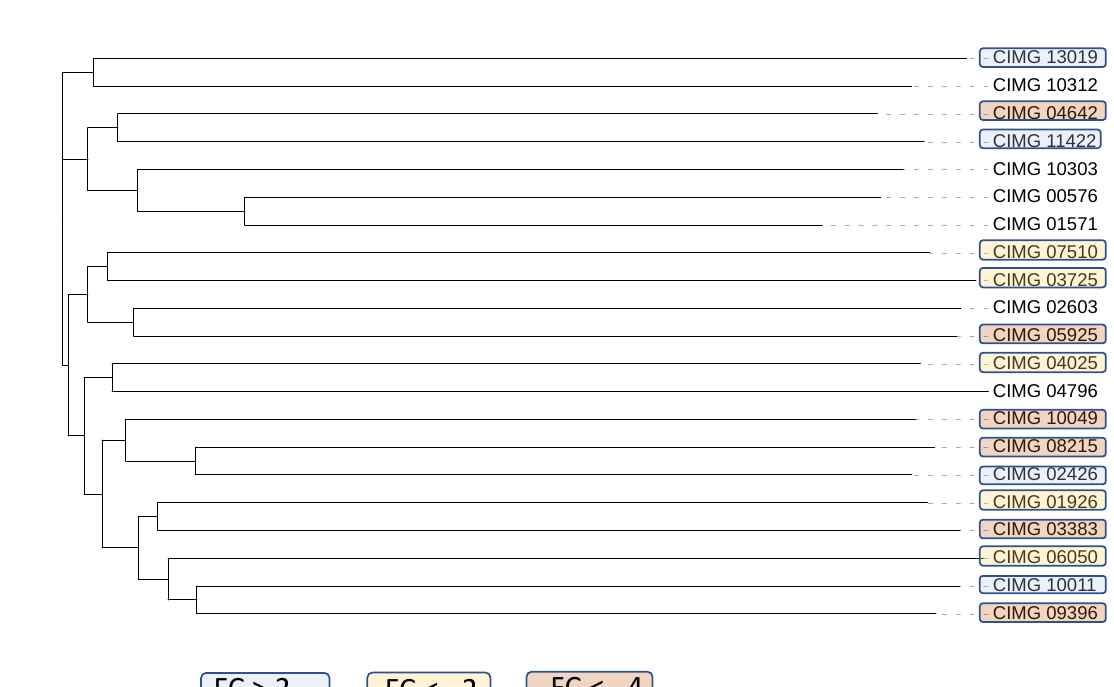
Figure 3. Phylogenetic tree of C2H2 transcription factors and FC. Legend: Phylogenetic tree was built on protein sequence. FC (young spherule/mycelium) values of C. immitis C2H2 transcription factors. Gene IDs within tan boxes are downregu- lated more than 4-fold; those that are within yellow boxes are downregulated more than 2-fold but less than 4-fold; those not within boxes are not significantly differentially expressed and those within blue boxes are upregulated more than 2-fold. None of these genes were upregulated more than 4-fold. All values are